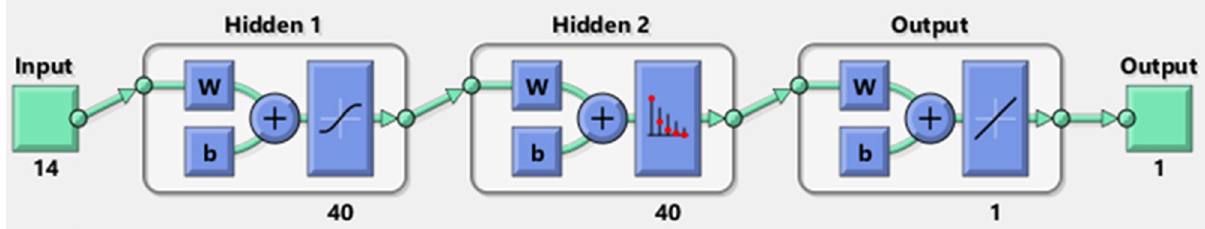
Figure 1. Artificial neural network